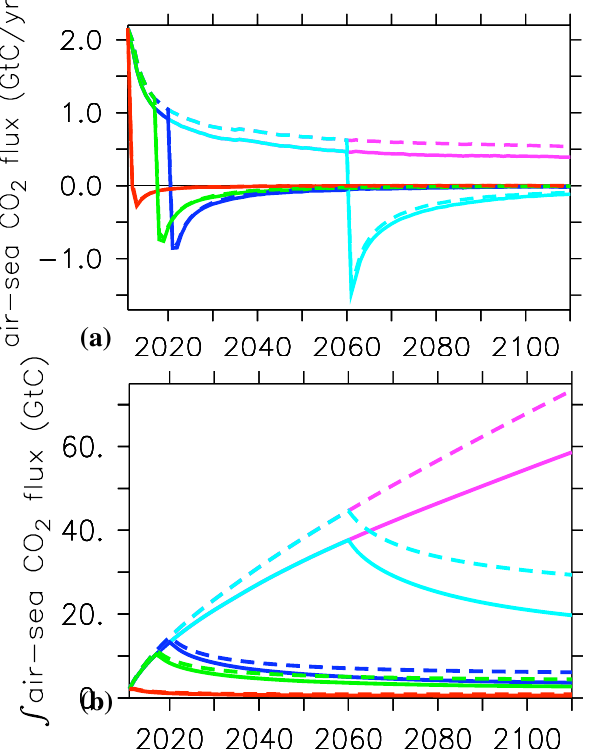
Fig. 6. (a) Simulated fertilization-induced annual air-sea CO 2 flux south of 30 ◦ S (dashed lines) and integrated over the global ocean (solid lines). Units are GtC/yr. (b) Cumulative temporal integral of the fertilization-induced change in air-sea flux of CO 2 south of 30 ◦ S (dashed lines) and for the global ocean (solid lines). Units are GtC. Coloured lines refer to the different fertilization experiments, stopping fertilization after 1 year (red), 7 years (green), 10 years (blue), 50 years (cyan) and not at all within the first 100 years (ma-